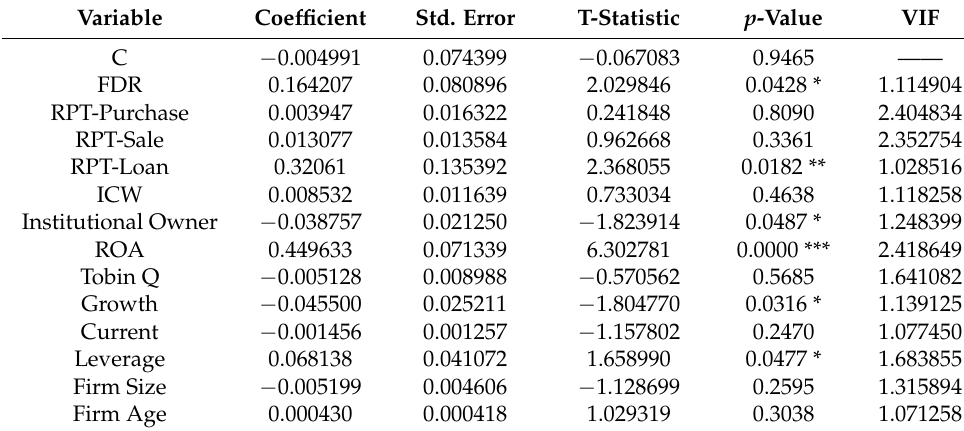
Table 6. Results of the research